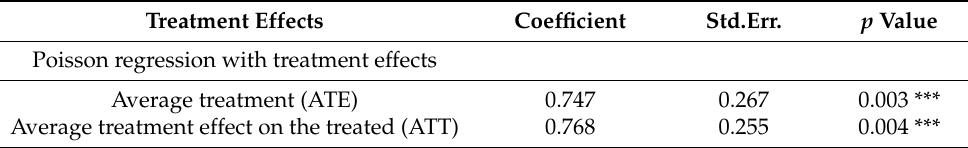
Table 5. Treatment effects on market participation of smallholder farmers. Treatment Effects Coefficient Std.Err. p Value Poisson regression with treatment effects Average treatment (ATE) 0.747 0.267 0.003 *** Average treatment effect on the treated (ATT) 0.768 0.255 0.004